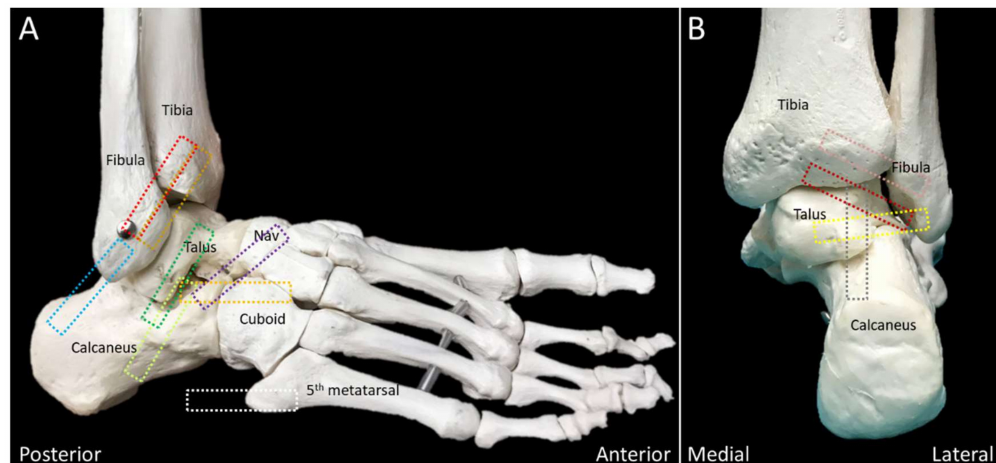
Figure 2. Colored dashed rectangles indicate the transducer positions through the lateral ( A ) and posterior ( B ) aspects of the ankle and foot. NAV, navicular.